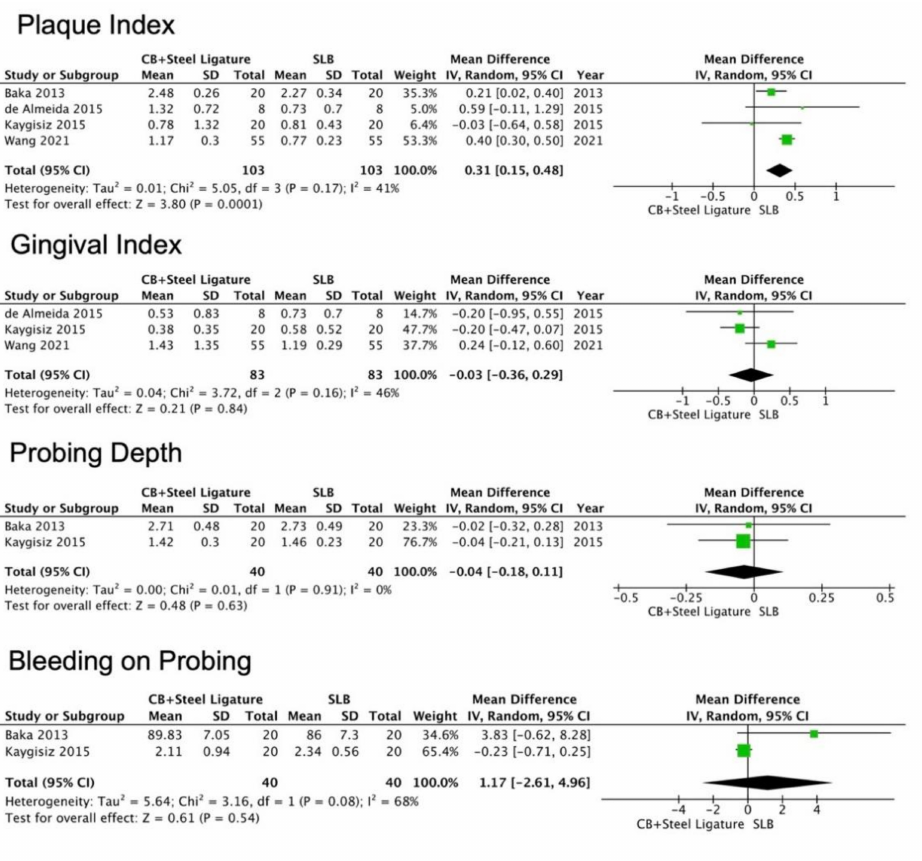
Figure 3. Forest plots for plaque index, gingival index, probing depth and bleeding on probing. Plaque index, gingival index and bleeding on probing were reported in percentages (%). Probing depth was reported in millimeters